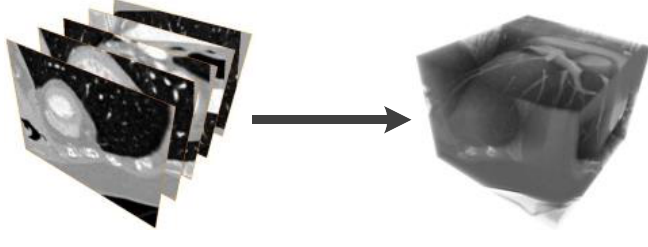
Figure 6. Cardiac CT images, slices and volume.